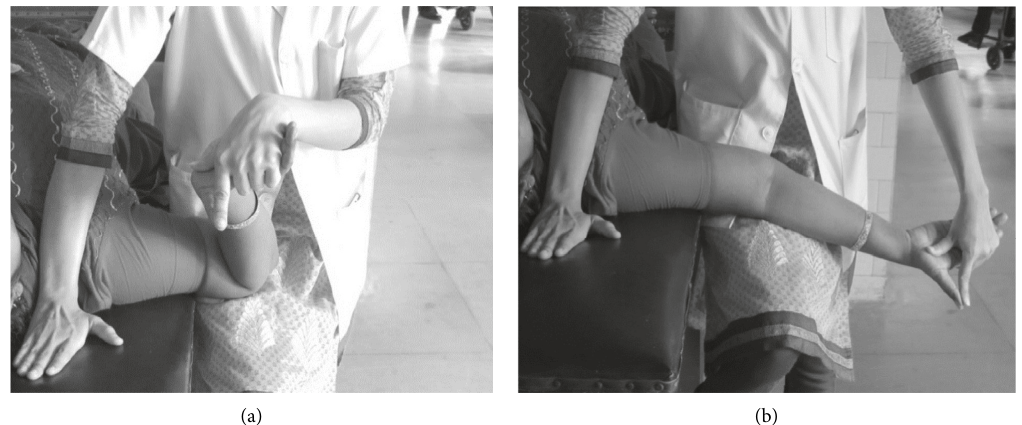
Figure 2: NT for median nerve ((a) elbow flexion with wrist extension; (b) elbow extension with wrist flexion).